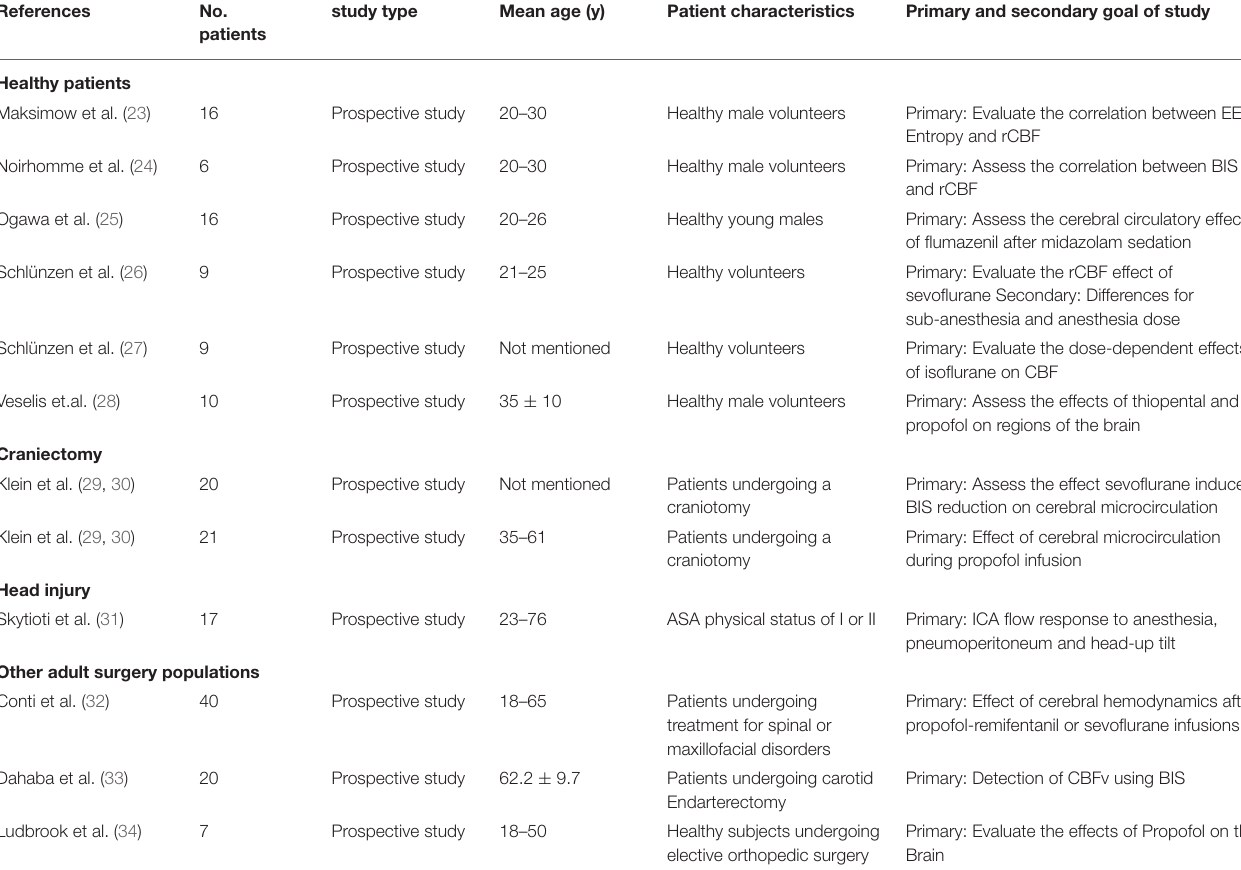
TABLE 1 | Human included studies–general characteristics and study